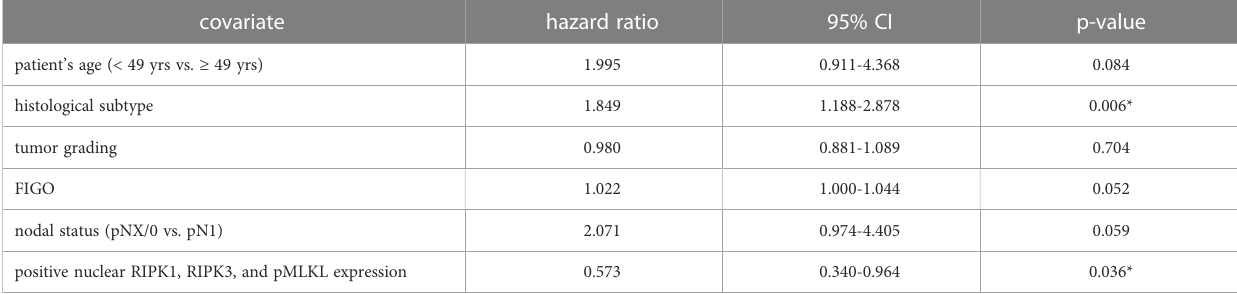
TABLE 8 Multivariate Cox regression analysis of cervical cancer patients ( n = 250) and their clinical and pathological characteristics including nuclear RIPK1-RIPK3-pMLKL co-expression regarding OS. covariate hazard ratio